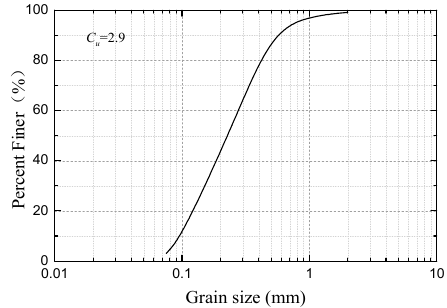
Figure 4. Particle size distribution curve. Table 2. Physical and mechanical properties of soil.